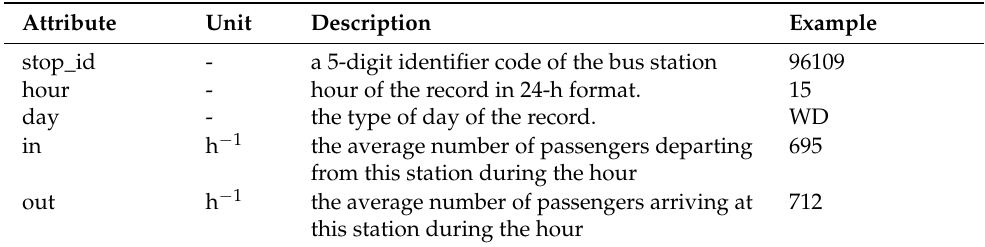
Table 7. Attribute list of the bus ridership